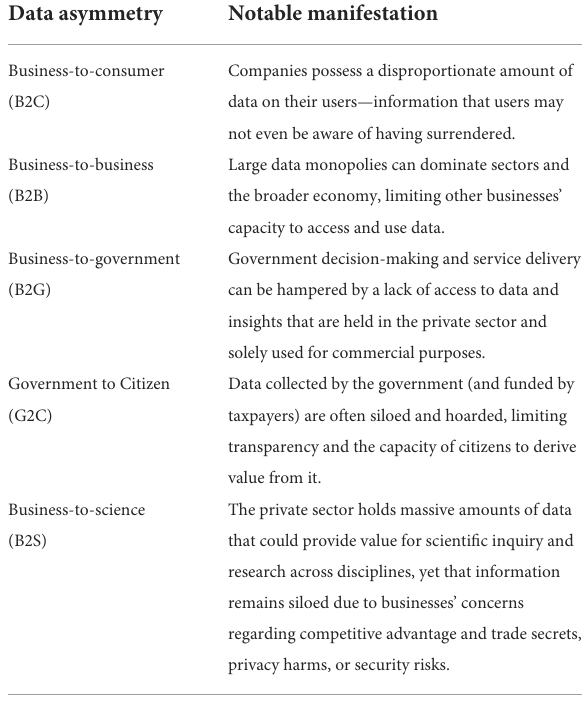
TABLE 1 Overview of types of data